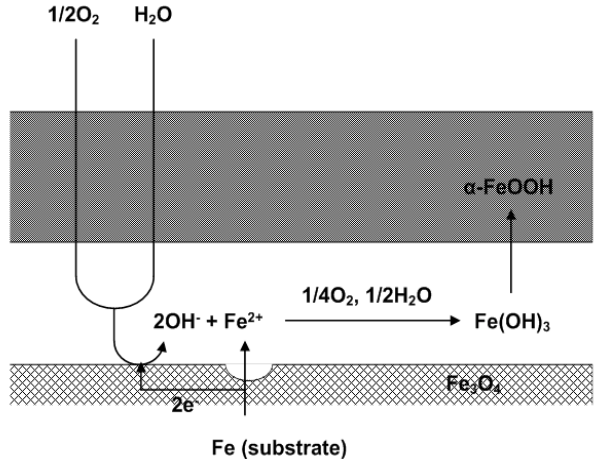
Figure 13. Schematic of the rust film formed on the steel at the initial stage of corrosion. Reproduced with permission from [18]. Copyright Elsevier, 2008. Metals 2017 , 7 , 182 17 of 20